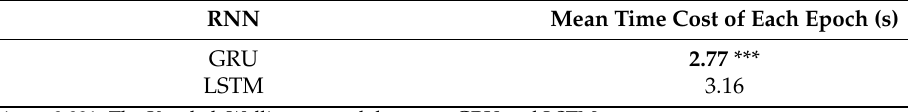
Figure 10. The time costs of LSTM and GRU. Table 4. The time costs of LSTM and Table 4. The time costs of LSTM and GRU.